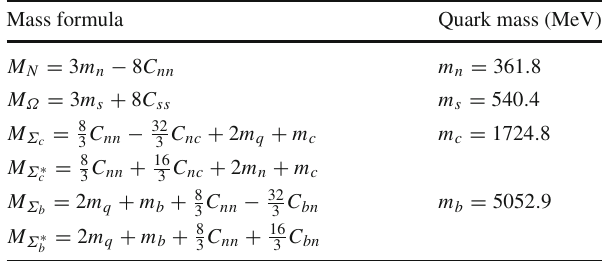
Table 5 The effective constituent quark masses extracted from con- ventional baryons Mass formula Quark mass (MeV)